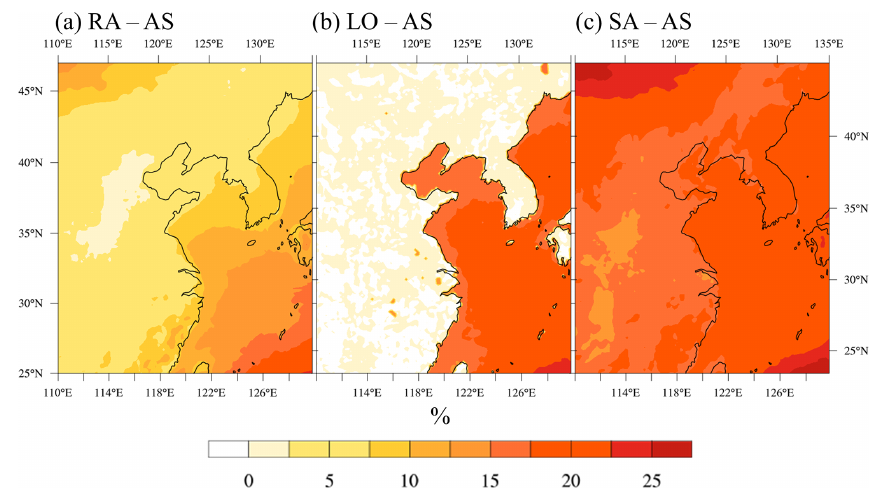
Figure 5. Percentage difference in the column-integrated CCN activation fraction at 0.6% supersaturation ( f CCN ) in AS and sensitivity simulations: (a) RA – AS, (b) LO – AS, and (c) SA – AS.